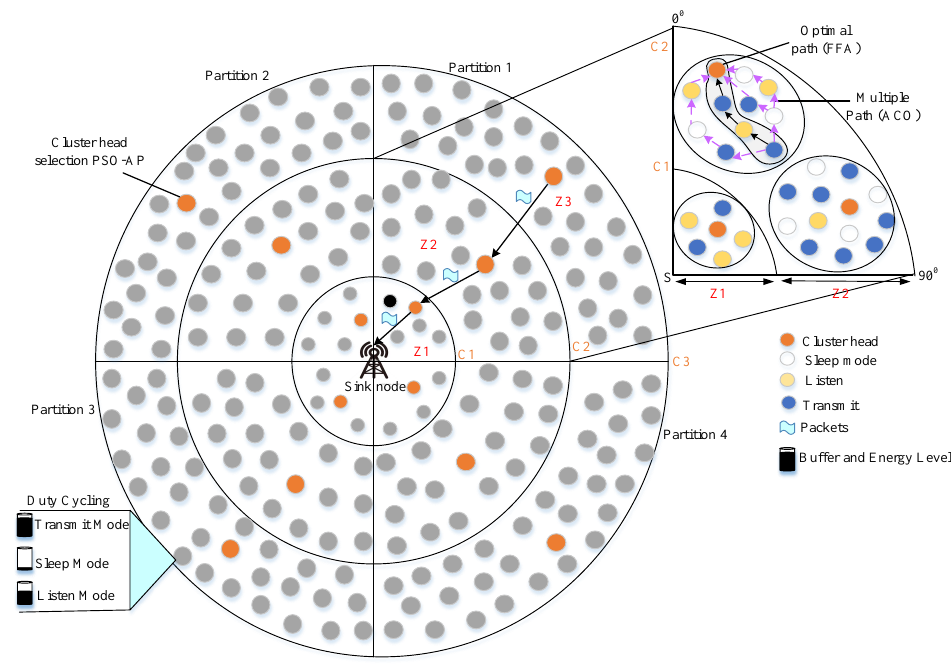
Figure 1. The architecture of proposed work.